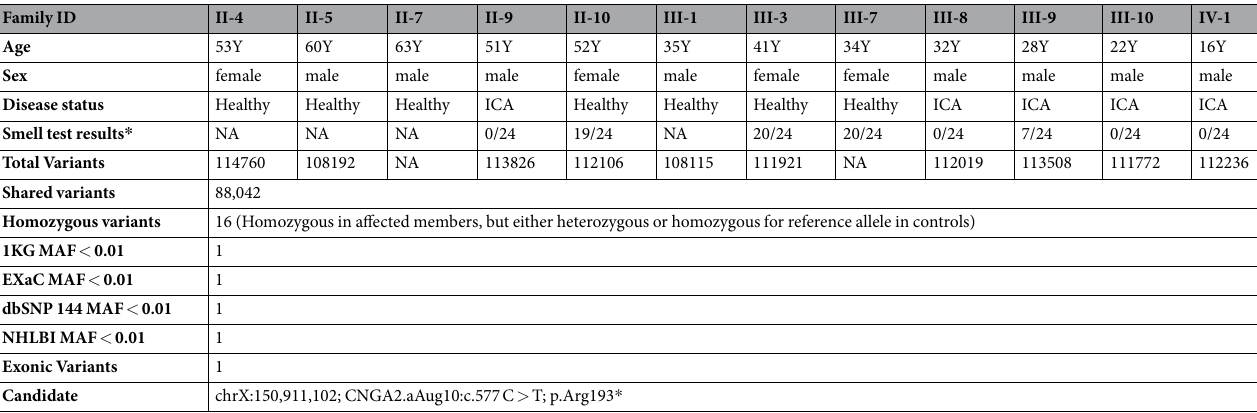
Table 1. ICA Family members ID and variants filtering steps. Y, year. NA, Not Available. ICA, Isolated Congenital Anosmia. * Based on Iran Smell Test. MAF, minor allele frequency. 1 KG, 1000 Genome project phase 3,. EXaC, Exome Aggregation Consortium version 0.3. dbSNP 144, Database of Single